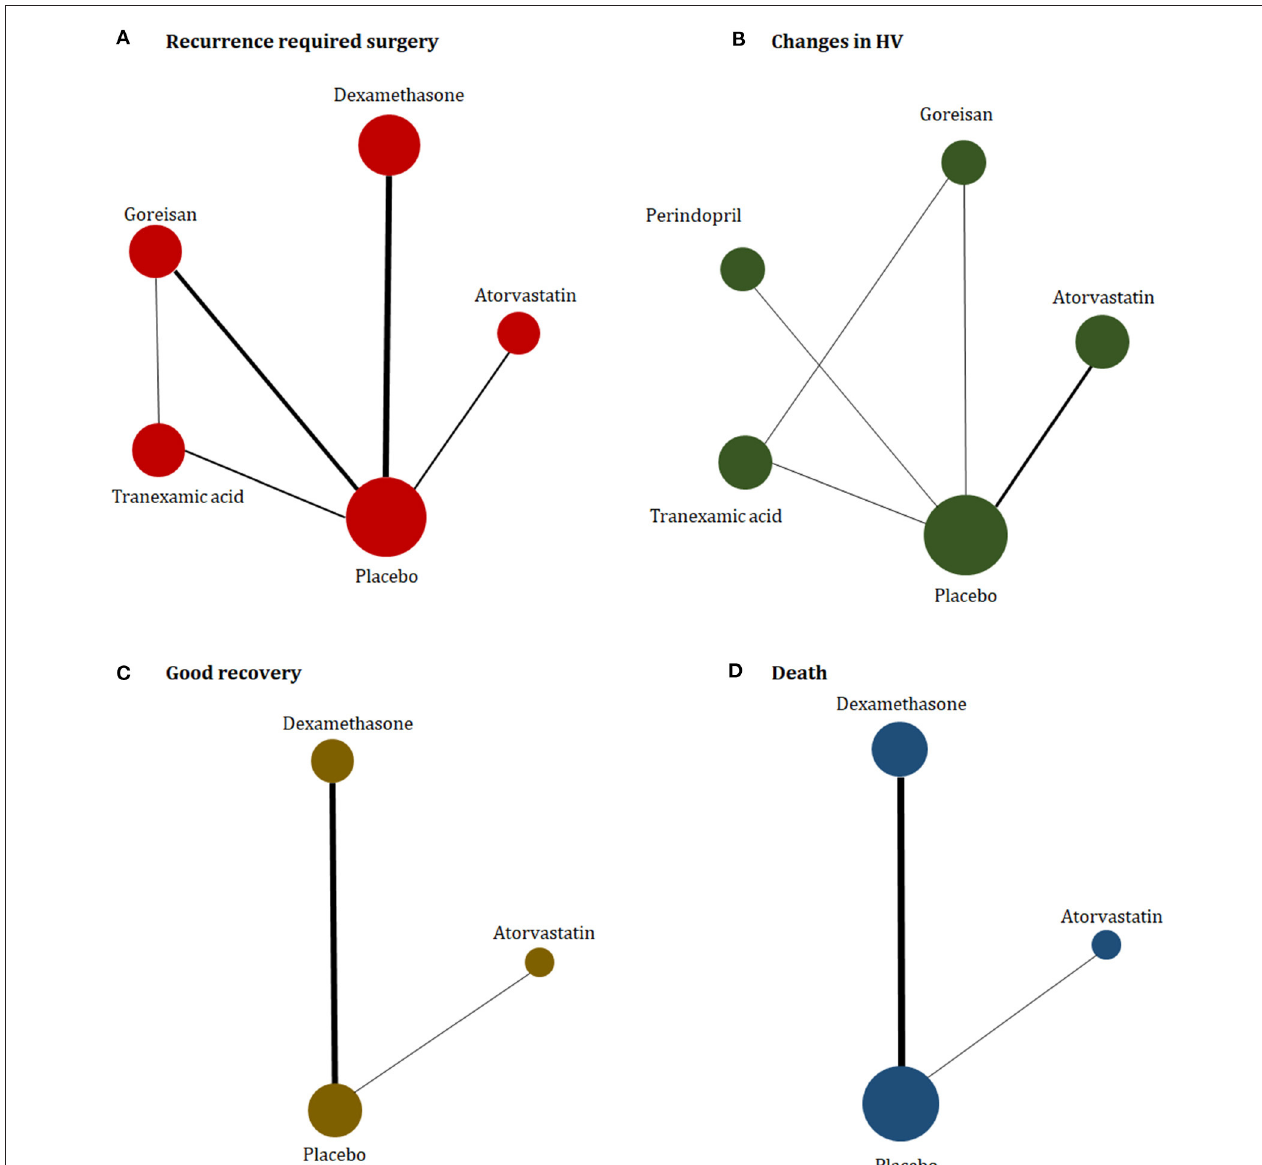
FIGURE 2 | Network plot of (A) recurrence required for surgery, (B) changes in hematoma volume, (C) good recovery, and (D) death. The width of the lines is proportional to the number of studies comparing every pair of treatments, and the size of each circle is proportional to the number of